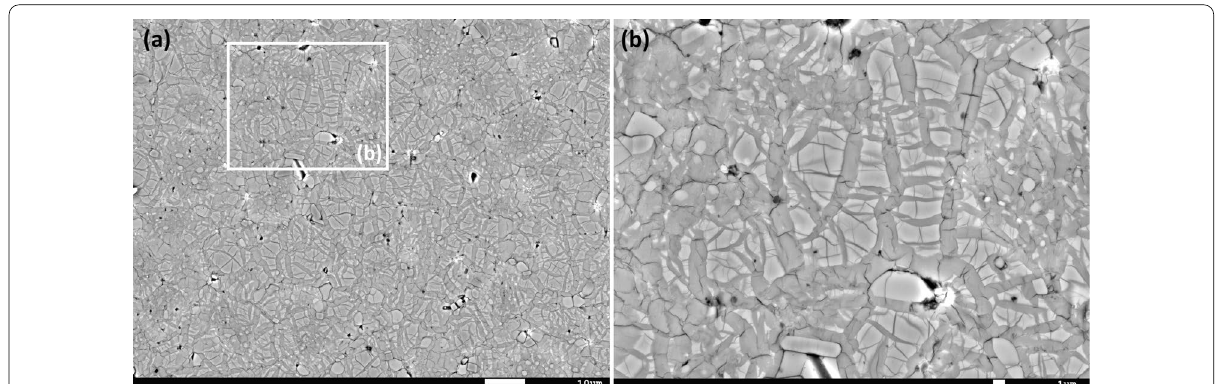
Fig. 7 BSE images showing back-transformation microstructures from bridgmanite to high-P clinoenstatite. a The back-transformation occurred in darker regions by both inter- and intra-crystalline processes at 7.9 GPa and 820 °C (Run M2715). b A high-magnification image of a white-colored box in a